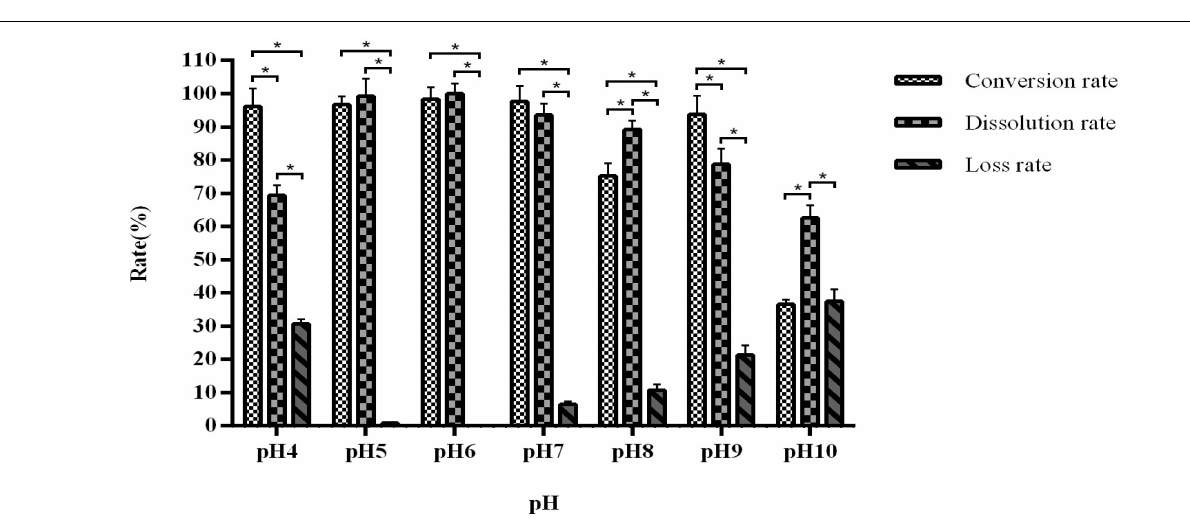
FIGURE 6 | The influence of pH on fermentation efficiency. *Indicates significance at the 0.01